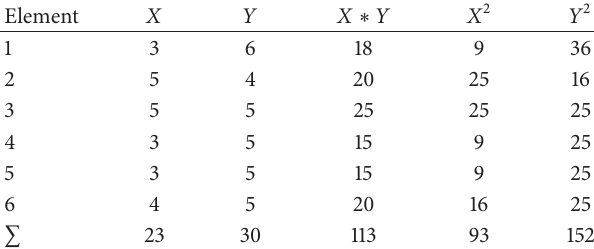
Table 3: Calculation for correlation coefficient.